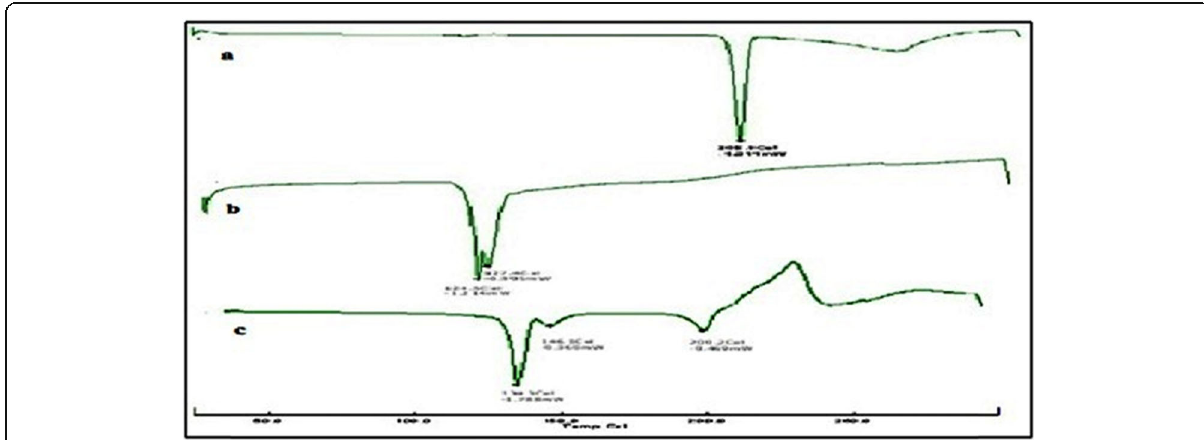
Fig. 2 DSC thermogram of a piroxicam, b sucralose, and c co-crystal